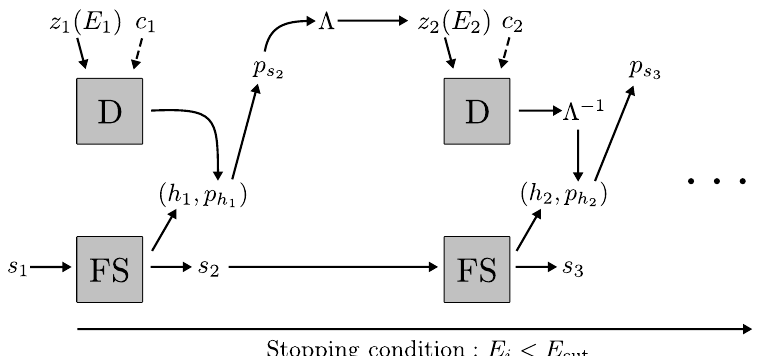
Figure 5: Illustration of ML HAD generating hadronization chains. Random variables z are passed through the decoder D with condition vector c to generate the hadron i i momentum, given the string energy E . A modified P YTHIA flavor selector FS, gener- i ates the new string flavor, s , and emitted hadron species, h . Before each emission, i + 1 i the string is boosted to its center-of-mass frame using a Lorentz transformation Λ